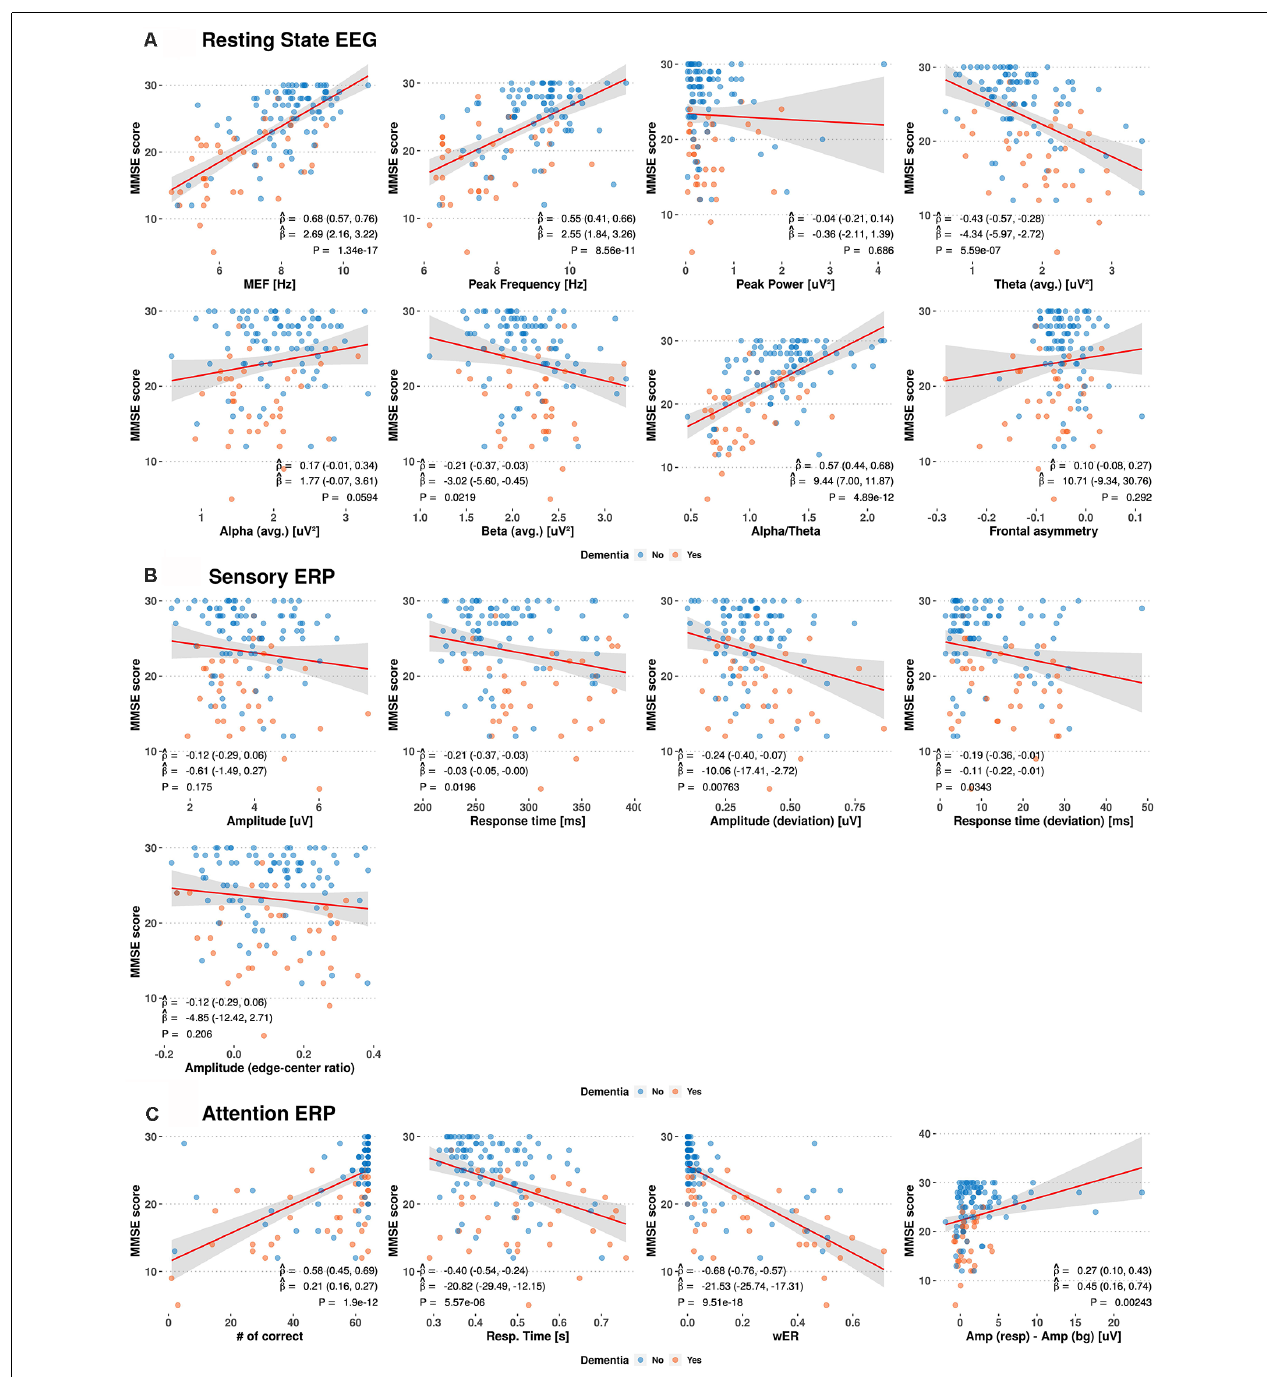
FIGURE 2 | Scatterplots between Mini-Mental Status Examination (MMSE) scores and electroencephalography (EEG)/event-related potential (ERP) variables. The red and blue circles indicate the dementia and non-dementia subjects, respectively. The red line and shaded area show the estimated regression curves and 95% confidence intervals derived from univariate regression analysis. The estimated Pearson correlation coefficient ( ˆ ρ ), regression coefficient ( ˆ β ), and p -value (P) for each EEG/ERP variable are shown with their 95% confidence intervals (MEF, median frequency; wER, weighted error percentile).